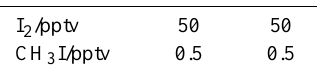
Table 2. Summary of the performance of the IO measurement tech- niques. Instrument detection limits are an average daytime value for 8 September. Detection limits are quoted as mixing ratios except the CMAX-DOAS measurements, which is a slant